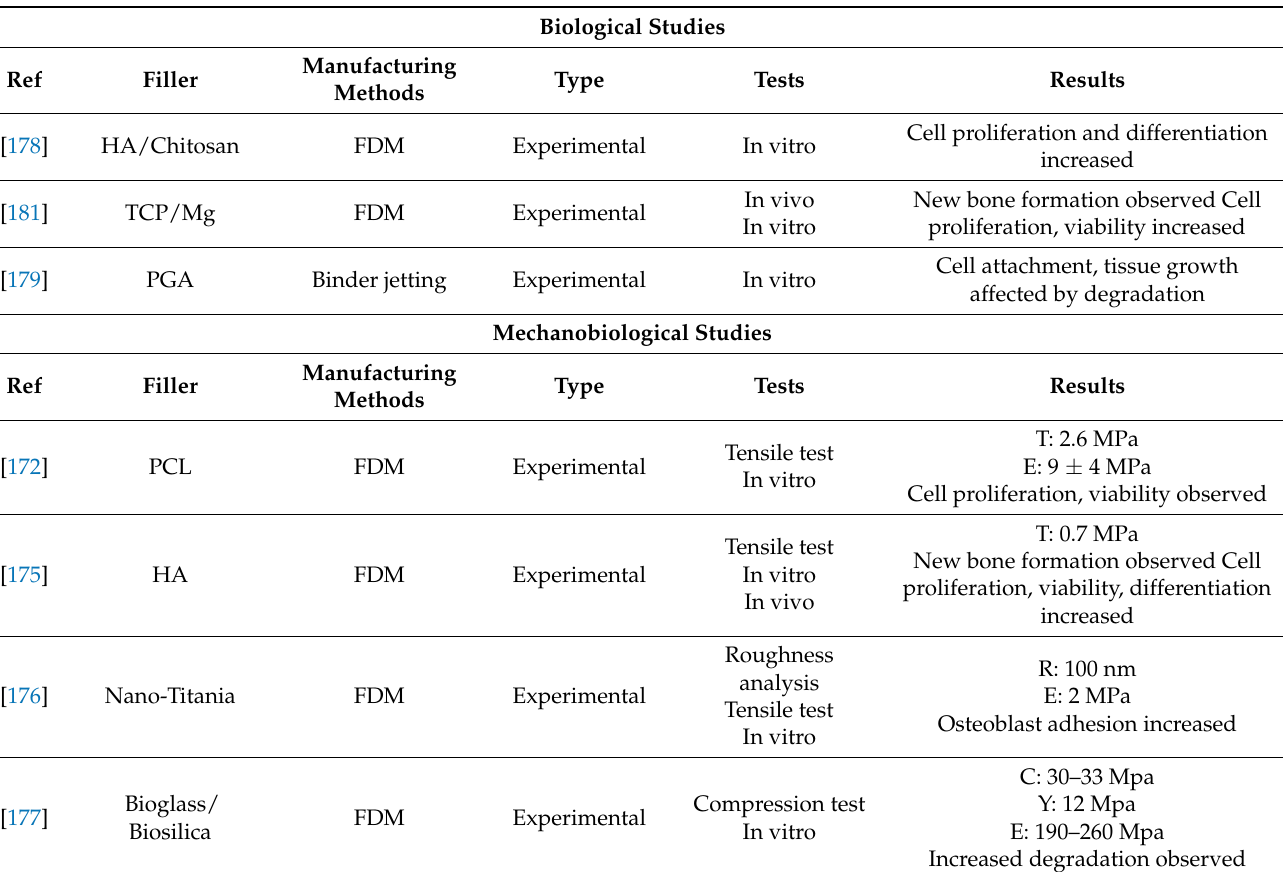
Table 11. Mechanobiological literature of PLGA and its composite material; C: compressive strength, T: tensile strength, D: displacement, Y: yield strength, E: modulus of elasticity, WCA: water contact angle, B: bending strength, R: